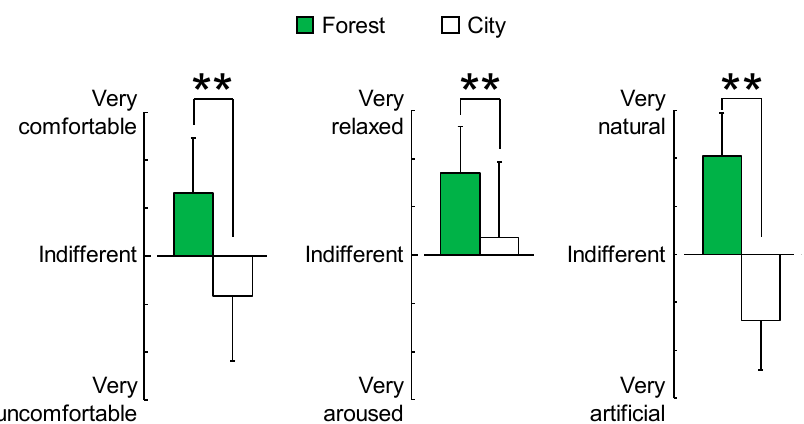
Figure 5. Subjective feelings after viewing forest and city areas, assessed using the modified semantic differential method. Data are shown as means ± standard deviation ( n = 65). ** p < 0.01, Wilcoxon signed-rank test (one-sided).